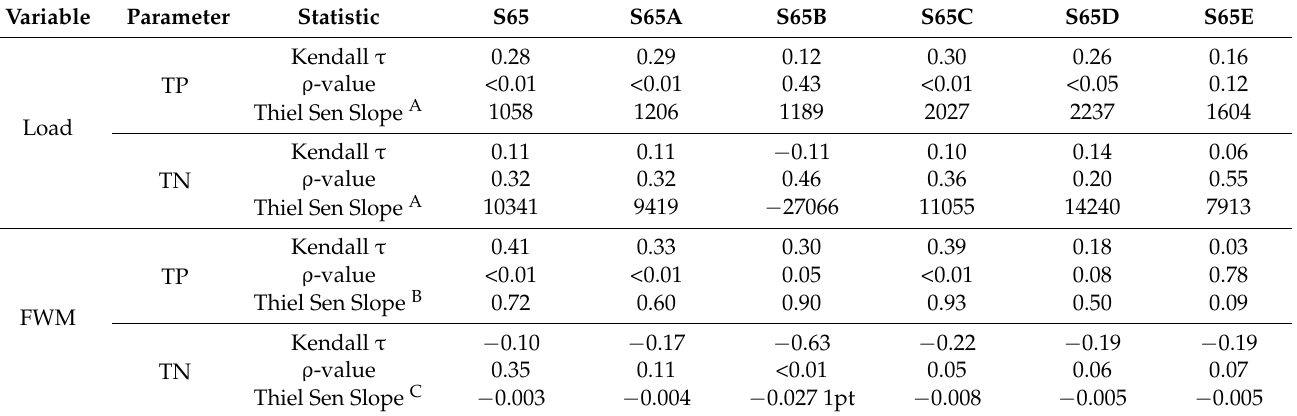
Table 3. Total phosphorus (TP) and total nitrogen (TN) annual load and flow-weighted mean concentration Mann–Kendall long-term trend results for water control structures along the Kissimmee River